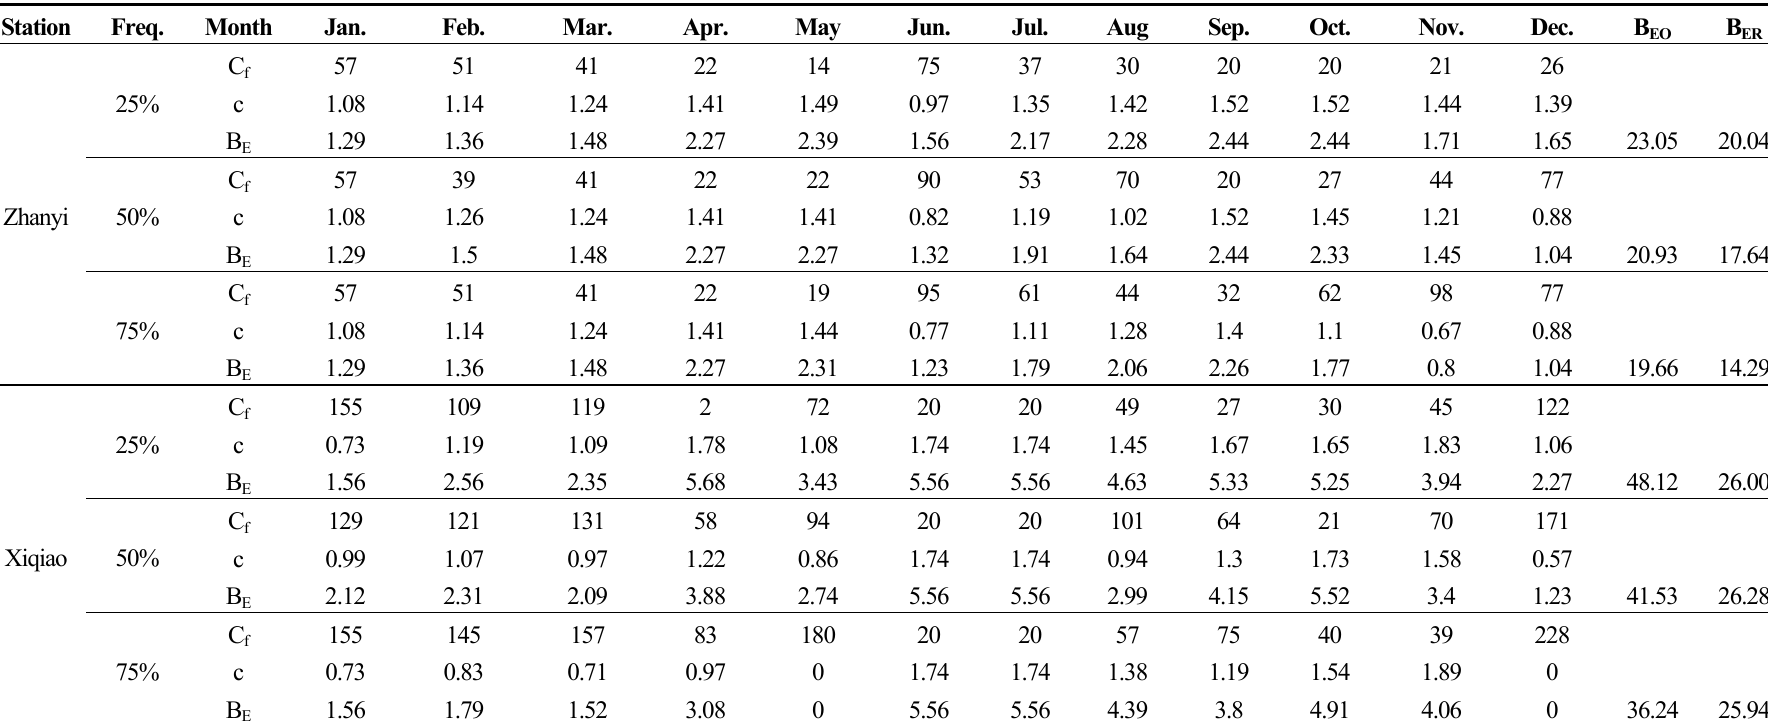
Table 1. Water quality benefits from optimal reoperation (B per ton; B is millions of Yuan. Freq. is the abbreviation of frequency. E Station